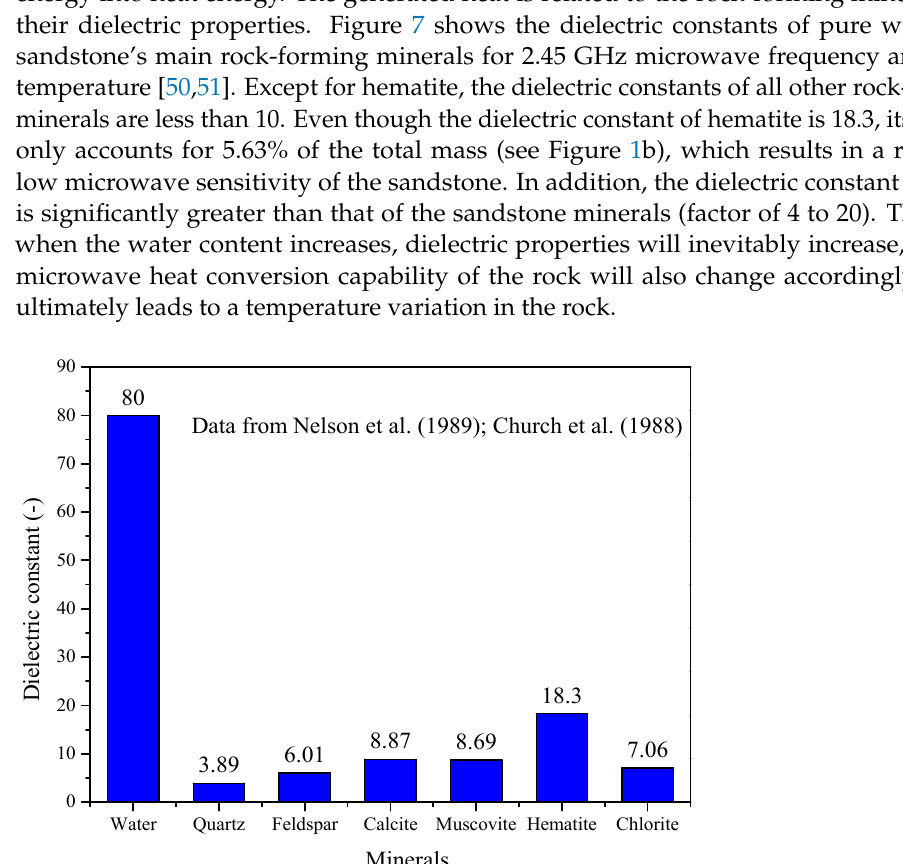
Figure 7. Dielectric constants of pure water and sandstone’s main rock-forming minerals [50,51].